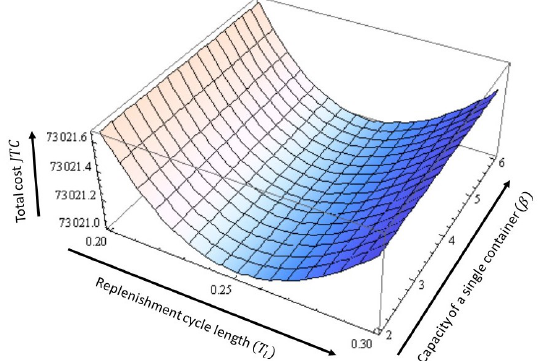
Figure 5. Total cost (JTC) for the CLSC versus capacity of a single container ( β ) and replenishment cycle length ( T l ) when s m and s l are fixed, β and T l are